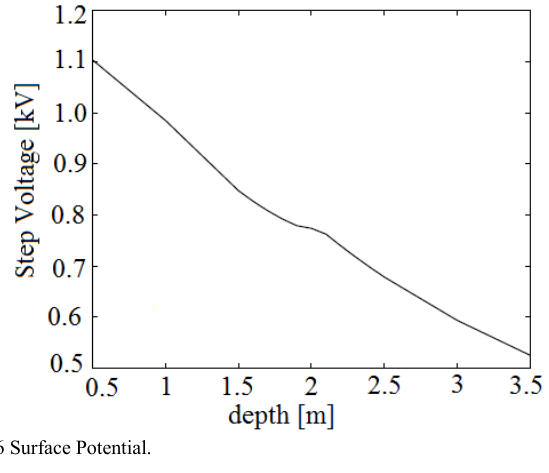
Fig. 16 Surface Potential.